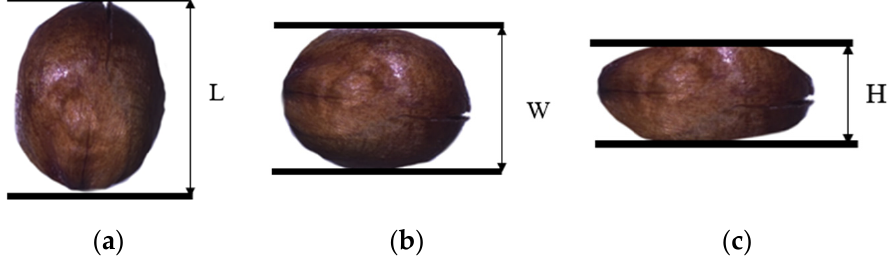
Figure 2. Triaxial dimensions of sorghum seeds. ( a ) Length. ( b ) Width. ( c ) Height. The triaxial arithmetic means diameter D a and geometric mean diameter D g